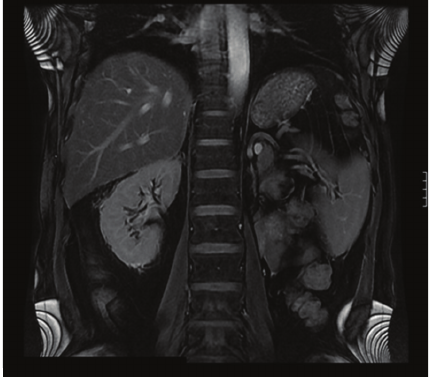
Figure 3: Postoperative magnetic resonance imaging (MRI) of the patient (6 months of follow